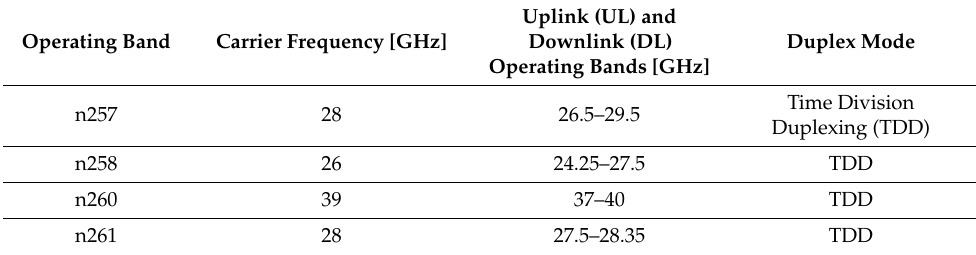
Table 1. Frequency operating bands of New Radio (NR) in Ka-Band spectrum